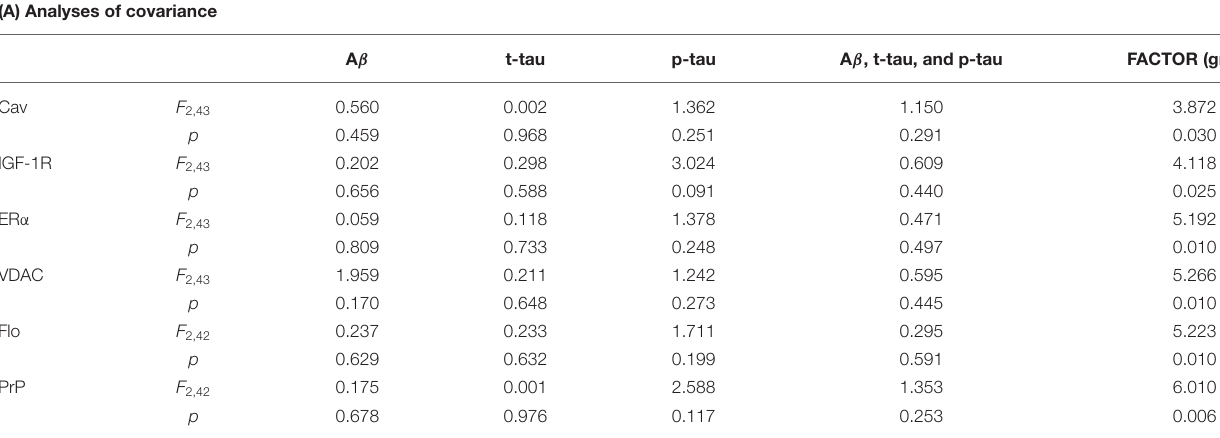
TABLE 3 | Relationships between ER-signalosome proteins and classical AD biomarkers. (A) Analyses of